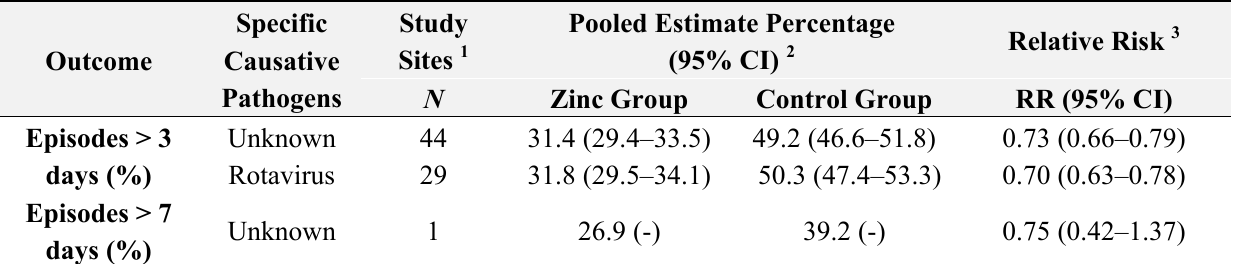
Table 5. Pooled relative risk of select outcomes for Chinese